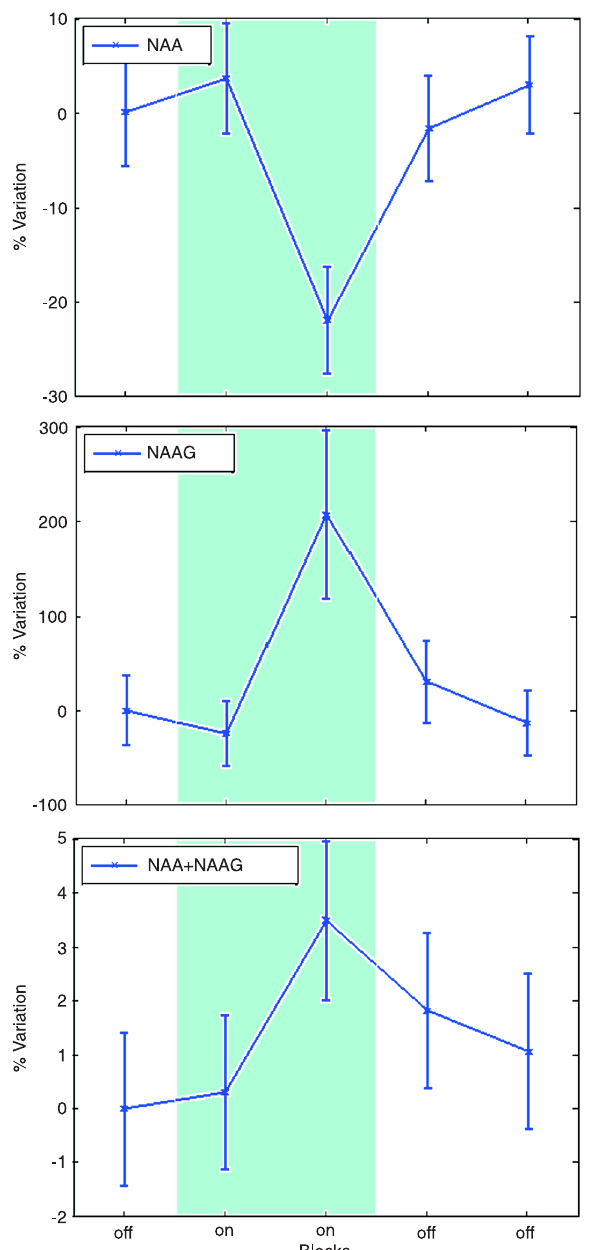
Figure 2. Changes of N-acetyl-L-aspartate (NAA), N-acetyl-as- partyl-glutamate (NAAG) and NAA+NAAG in response to stimu- lations. Shaded regions correspond to stimulation periods. Error bars correspond to propagation of the LCModel quantification